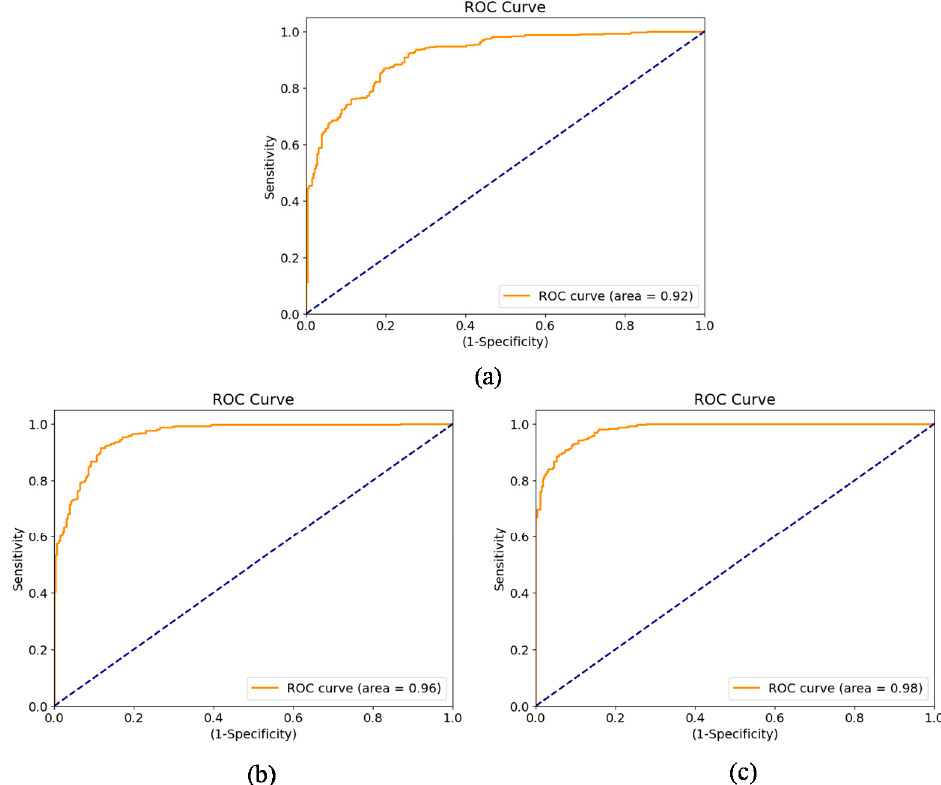
Figure 3. Disease progression performance with ( a ) image-based sequence learning, ( b ) lung-based sequence learning, and ( c ) zone-based sequence learning. [The dotted blue line (added for reference) is the ROC Curve of the random guess, representing no predictive capability].